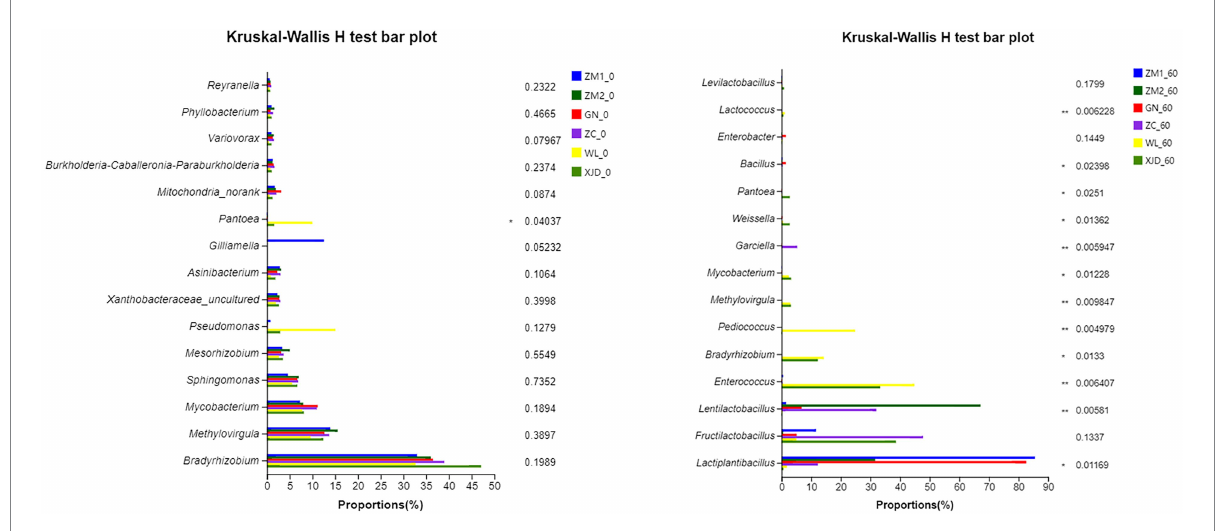
FIGURE 4 Comparison of microbial variations using the Kruskal-Wallis H test for alfalfa raw material and silage. ZC, Zhongcao No. 3; ZM1, Zhongmu No. 1; ZM2, Zhongmu No. 2; GN, Gongnong No. 1; WL, WL168; XJD, xinjiangdaye; 0, 0 day of ensiling; 60, 60 days of ensiling.